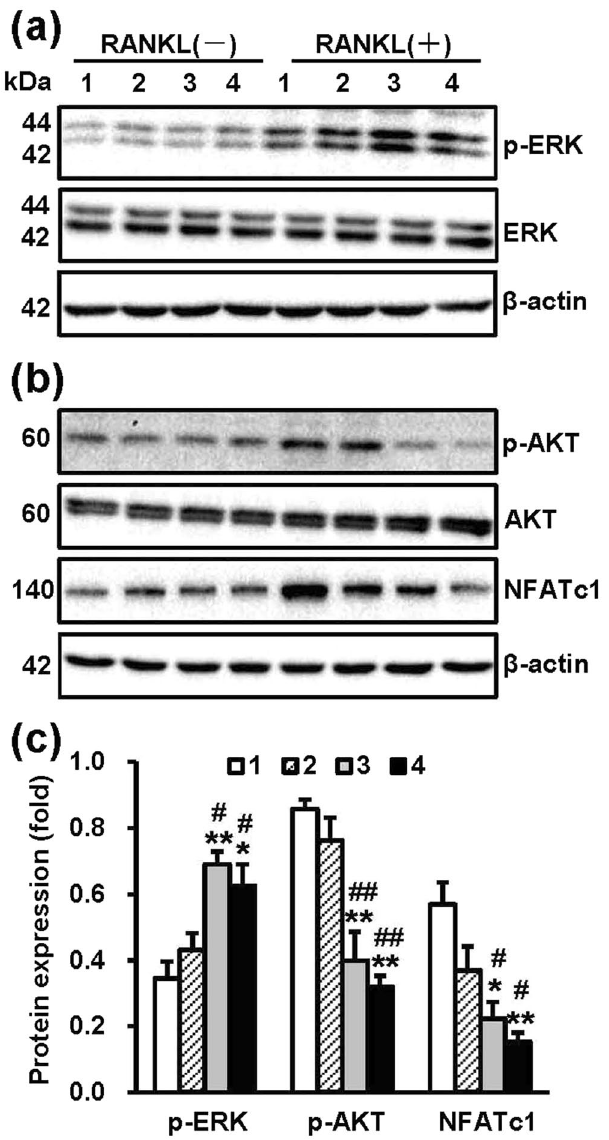
Figure 7. NT-Sr promote RANKL-induced phosphorylation of ERK and inhibit the Akt/NFATc1 pathway. RAW264.7 cells were cultured on different samples for 3 d and stimulated with or without 100 ng/mL RANKL for 30 min, and the total protein was then collected for immunoblot analysis. ( a ) RANKL-induced phosphorylation of ERK, ( b ) p-Akt and NFATc1 were detected using β -actin, total ERK and Akt as loading controls. ( c ) A quantitative analysis of the band densities was performed, and the band densities were normalised to the loading controls. Full-length blots are presented in Supplementary Figure 4. The numbers 1, 2, 3 and 4 in the figure represent Ti, TiO 2 -NTs, NT-Sr1h and NT-Sr3h, respectively. * , ** p < 0.05 and 0.01, respectively, compared with the Ti group, and #,## p < 0.05 and 0.01, respectively, compared with TiO 2 -NTs. At least three independent experiments were analysed, and the data are presented as the means ±